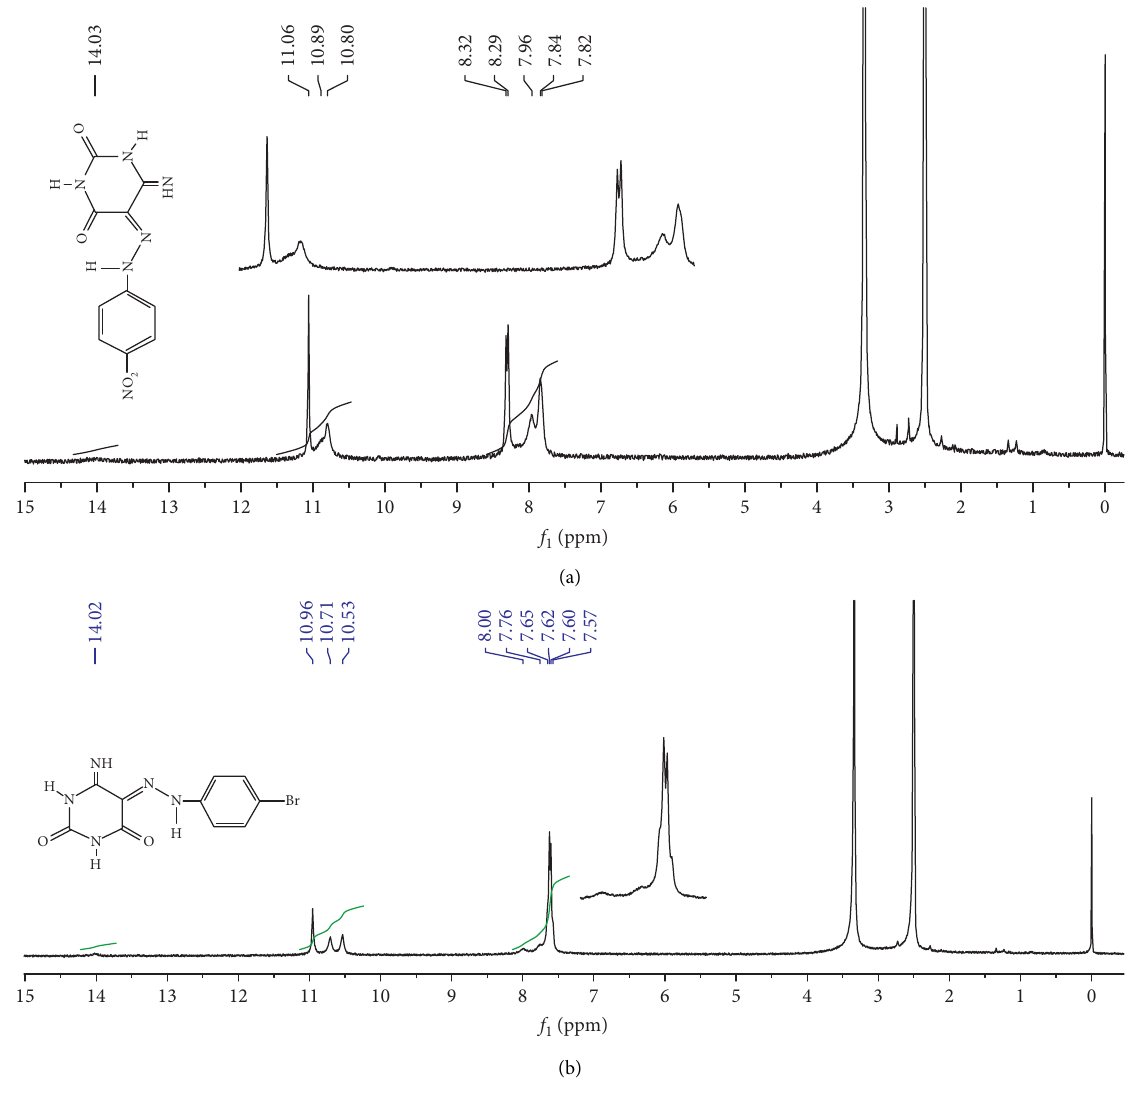
Figure 3: 1 H-NMR spectra of (a) dye I and (b) dye II.